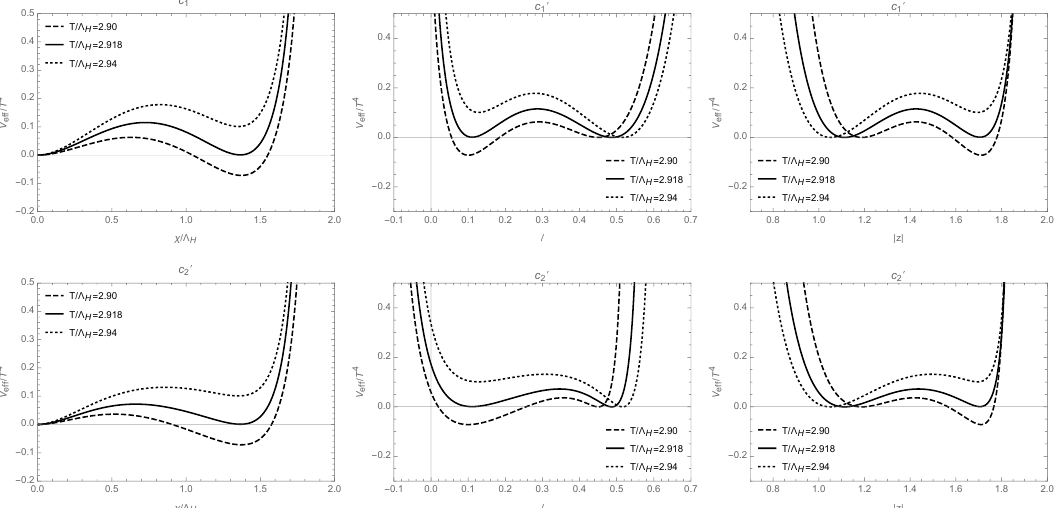
Figure 14 . The potential V e(cid:11) ( L; (cid:31); T ) =T 4 around T c; 6 = (cid:3) H = 2 : 918 as a function of (cid:31) (left), ‘ (center) and j z j (right) on the two di(cid:11)erent lines c 0 in (3.74) and